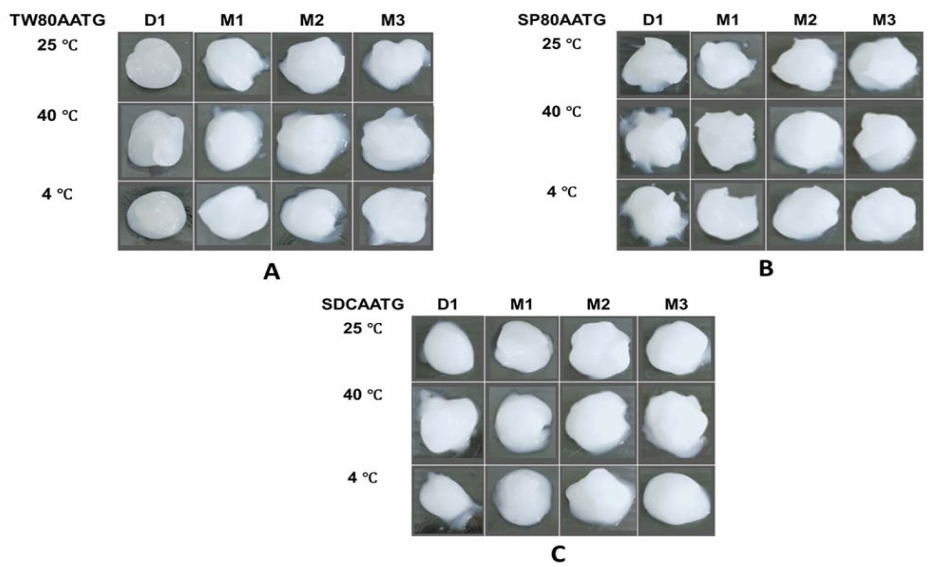
Figure 4. The physical appearance of AATGs during stability study period. ( A ) TW80AATG, ( B ) SP80AATG and ( C )